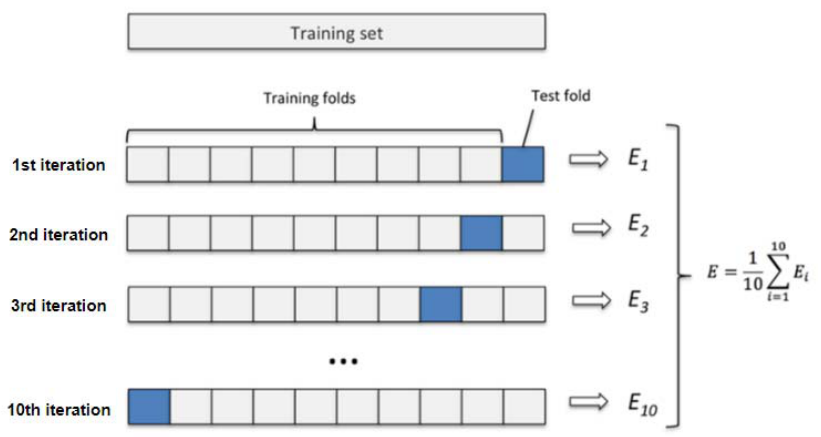
Figure 9. K-fold cross validation process [39].